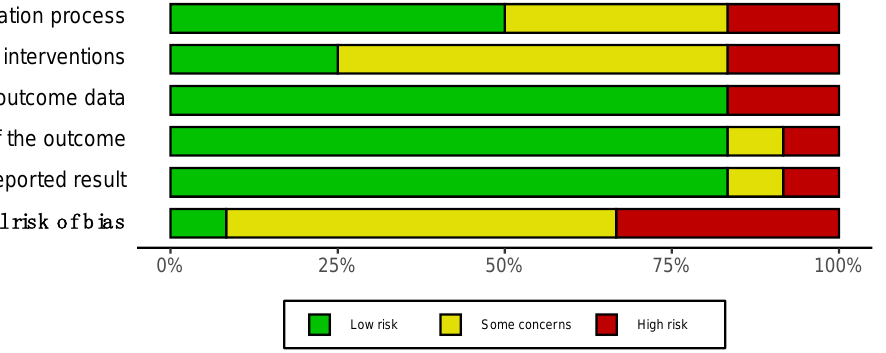
Figure 3. Overall risk of bias, with each category presented as percentage.